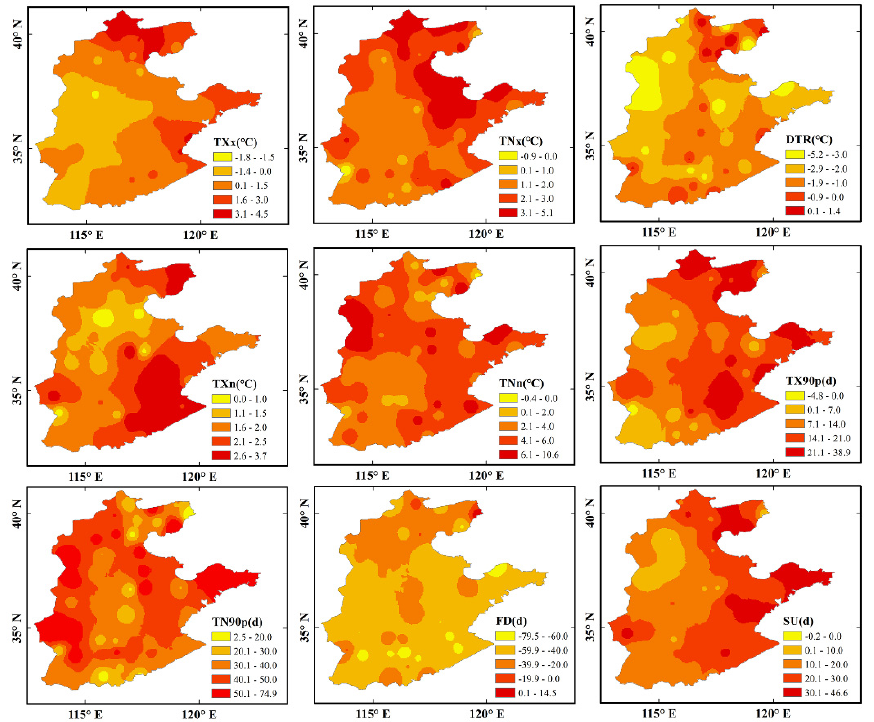
Figure 5. Spatial characteristics of changes in extreme temperature indices in the North China Plain from 2061 to 2100 under the SSP126 scenario.